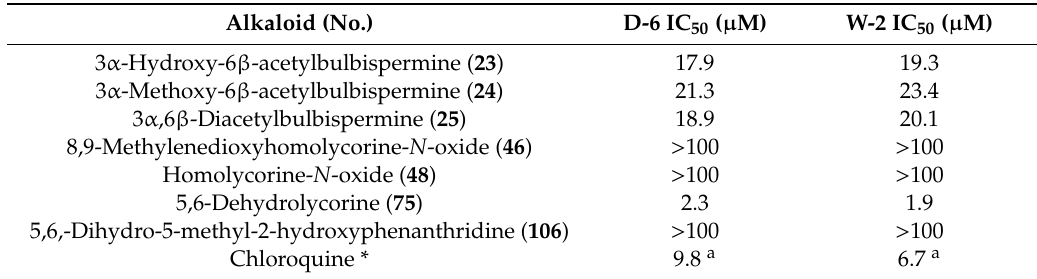
a Chloroquine data are expressed as IC